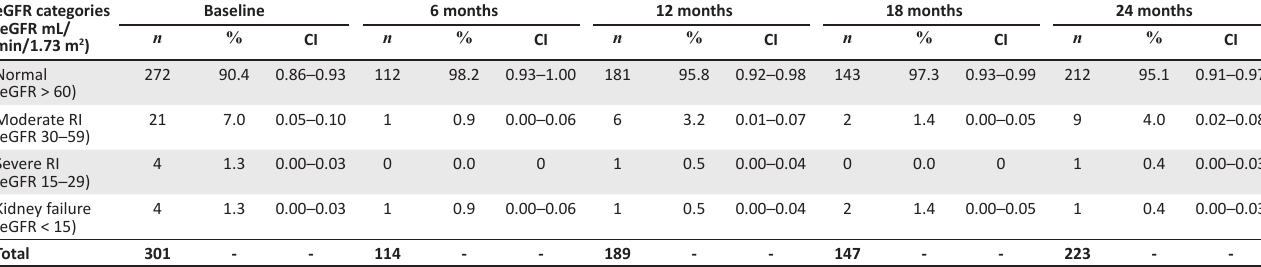
TABLE 5: Categories of renal impairment from baseline to 24 months on antiretroviral treatment. eGFR categories (eGFR mL/ min/1.73 m 2 )